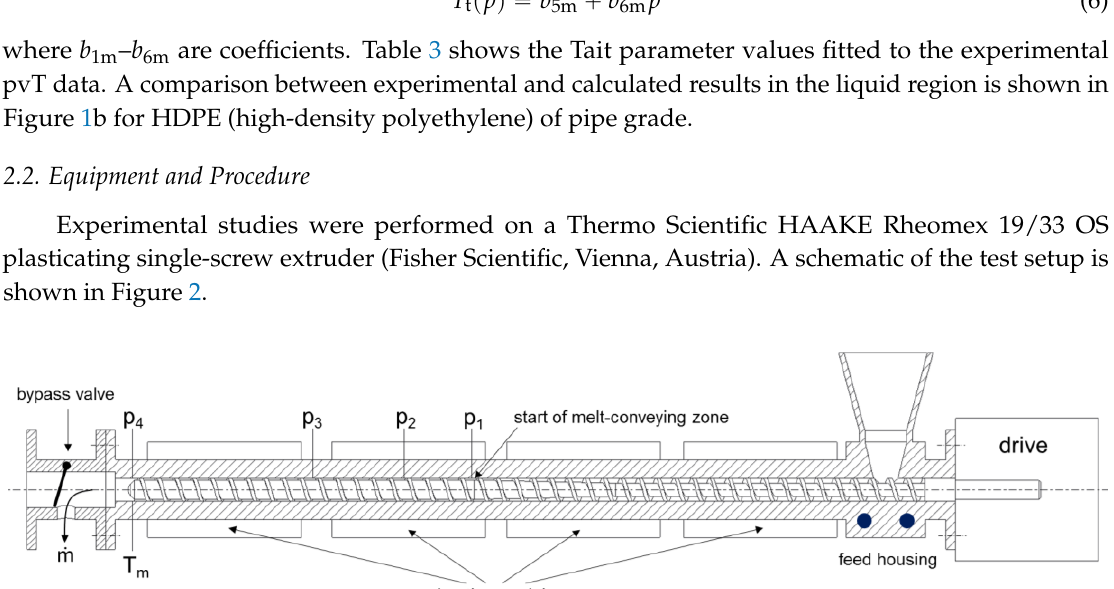
Figure 1. Comparison between experimental and calculated values: ( a ) Viscosity data of the polymer